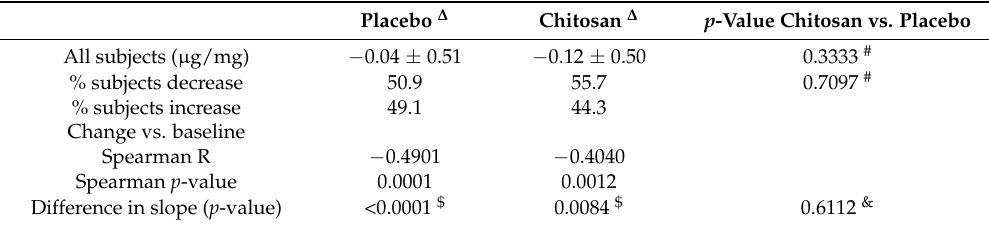
Table 7. Comparison of changes in serum R_campesterol induced by chitosan and placebo treatments. Placebo ∆ Chitosan ∆ p -Value Chitosan vs. Placebo